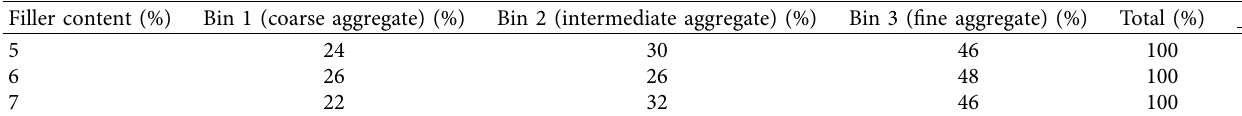
Table 6: Aggregate blending